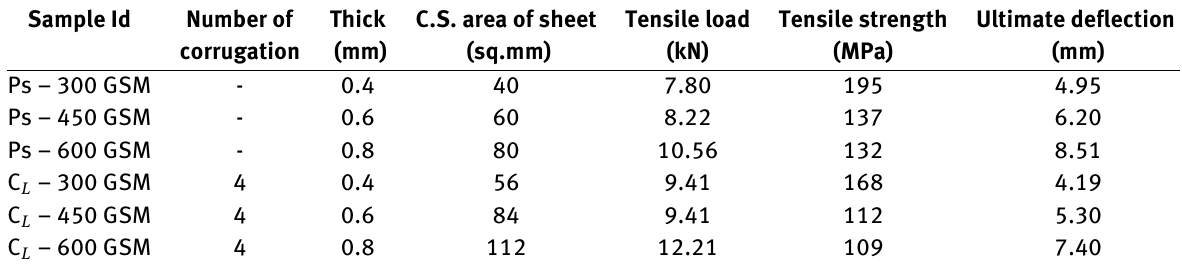
Figure 4: Casting, retrofitting and testing of beams: (a) Reinforcement grill; (b) Beams under curing; (c) Surface grinding; (d) Filling of Corru- gated portions; (e) Bonding of GFRP; (f) Beam strengthened with mechanical fasteners; (g) Loading setup; (h) Beam failure pattern Table 1: Tensile load test results for GFRP plain sheets and corrugated